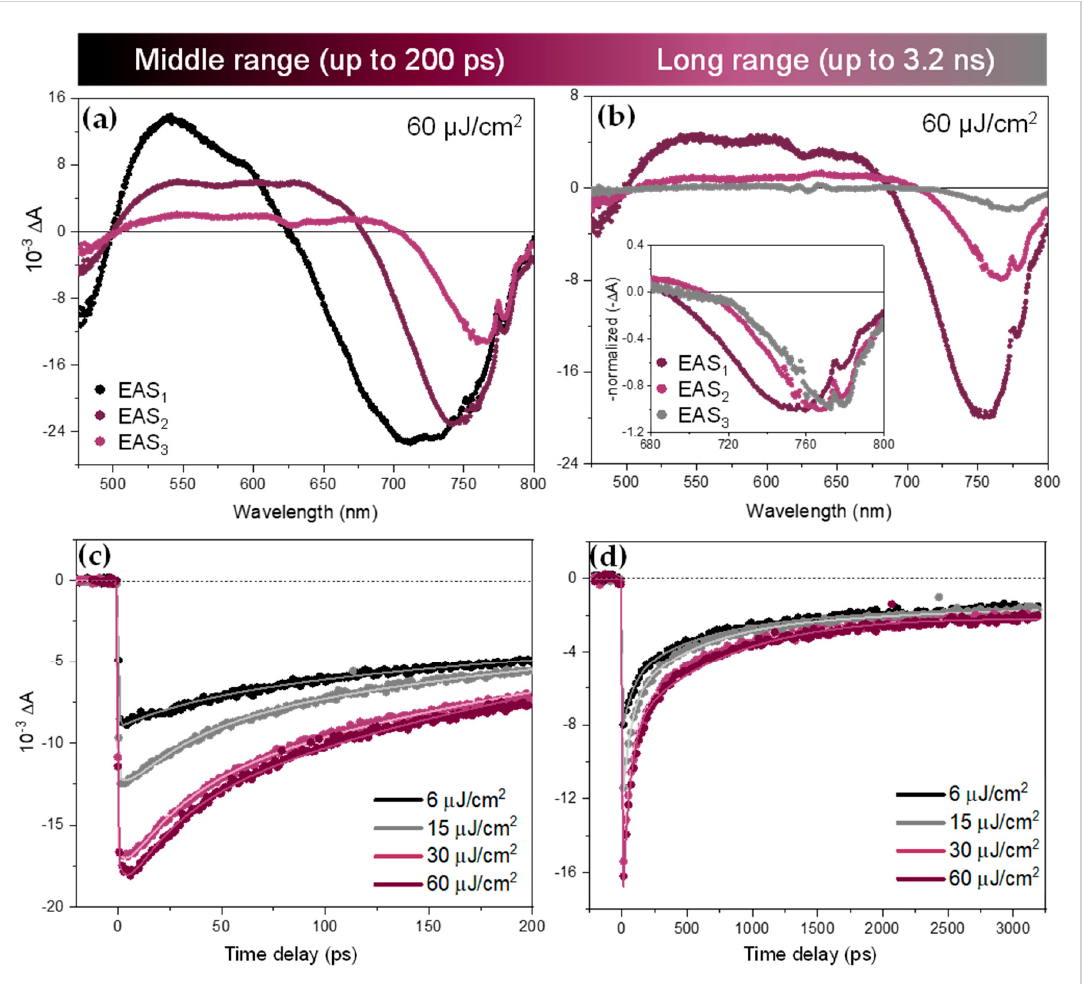
Figure 5. EAS of thick FAPbI 3 NPs excited at 630 nm for the ( a ) middle and ( b ) long time ranges at 60 μ J/cm 2 . Inset: normalized EAS. ( c ) Experimental TA decay traces (dots) and fitted traces (lines, from global analysis) of thick FAPbI 3 nanoplates detected at the band-edge (765 nm) for the middle and ( d )